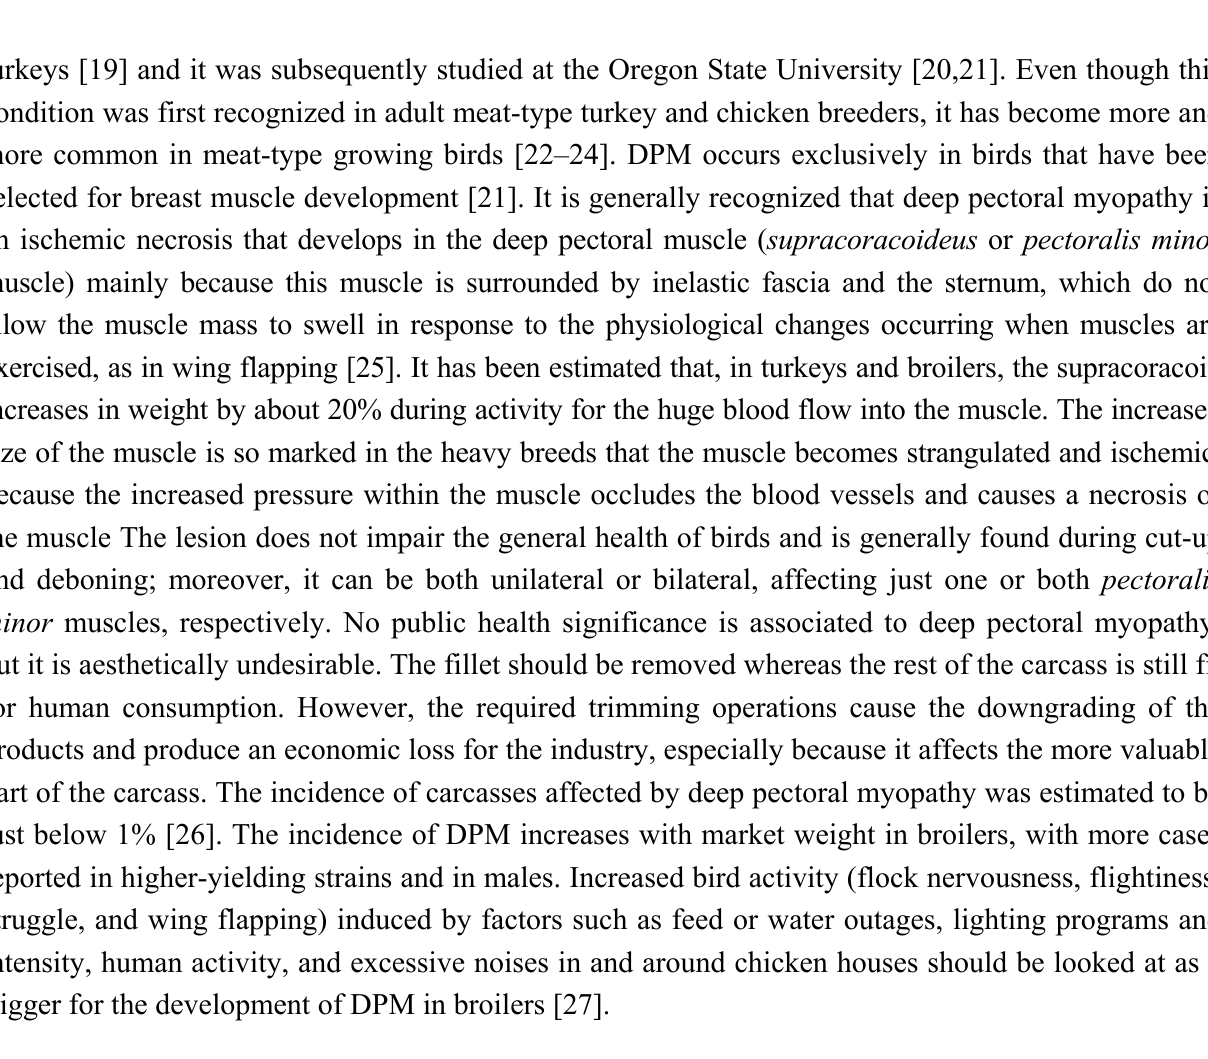
Figure 1. Deep pectoral myopathy [27]. With permission from Poultry Science